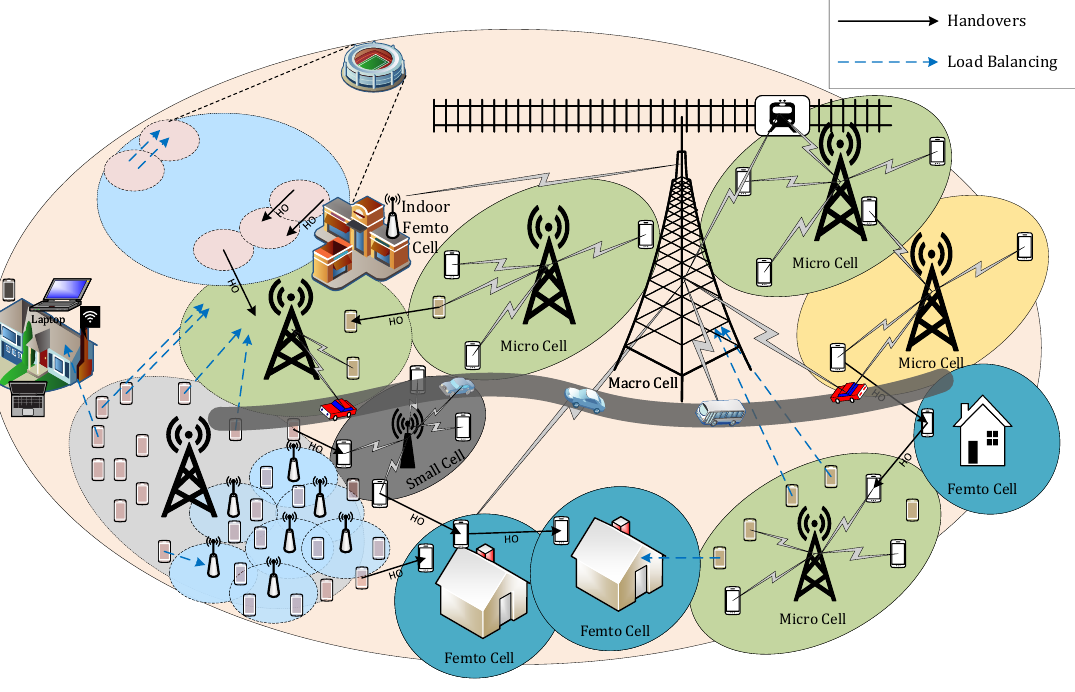
Figure 3. A simple HetNets